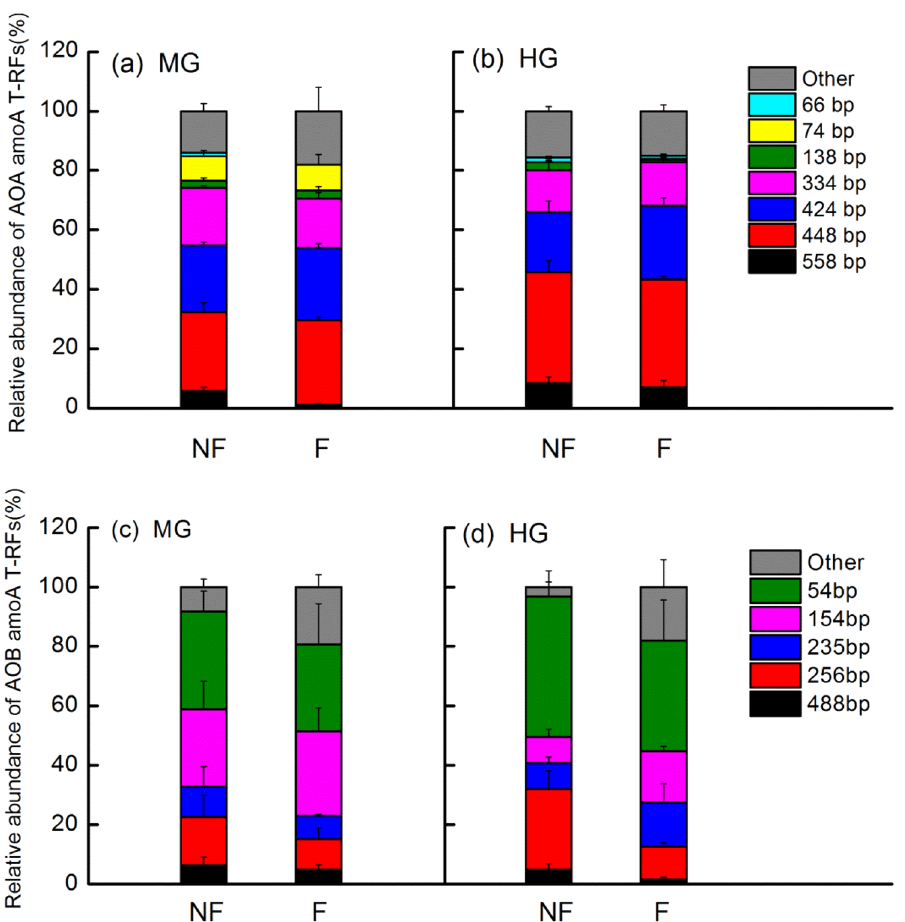
Figure 4. Terminal restriction fragment (T-RF) analyses targeting the functional gene amoA gene for AOA ( a,b ) and AOB ( c,d ) in soil. MG moderately grazed site, HG heavily grazed site, NF non-fenced, F fenced treatment. ANOVA results are available in Table S3 and Table S4. Correlation coefficient between soil physicochemical properties and T-RFs of AOB at HG site in Table